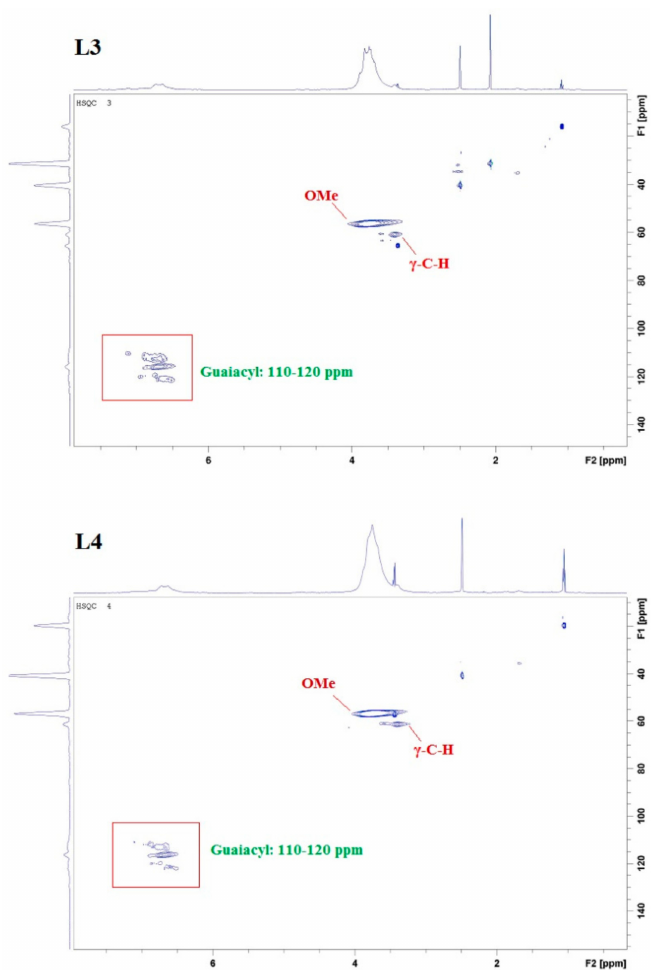
Figure 5. HSQC nuclear magnetic resonance (NMR) spectra of kraft lignin purification fractions L1, L2, L3, and L4; specifying in particular methoxy (OMe) signals, γ -C–H signals, and G-unit